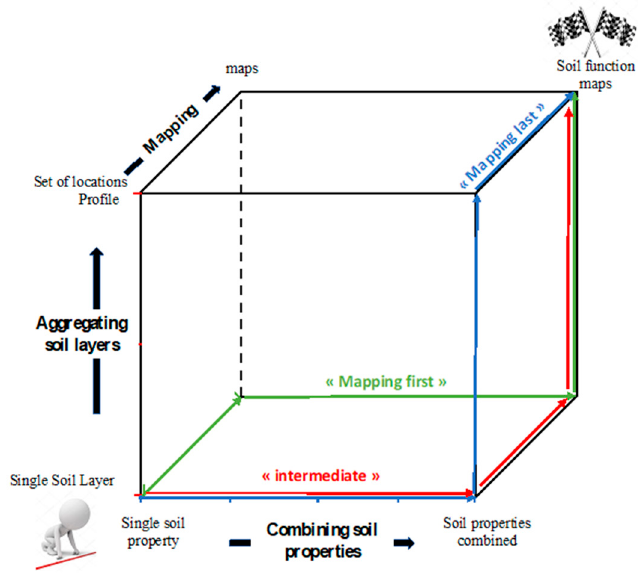
Figure 1. Three examples of computing trajectories for producing soil function maps .